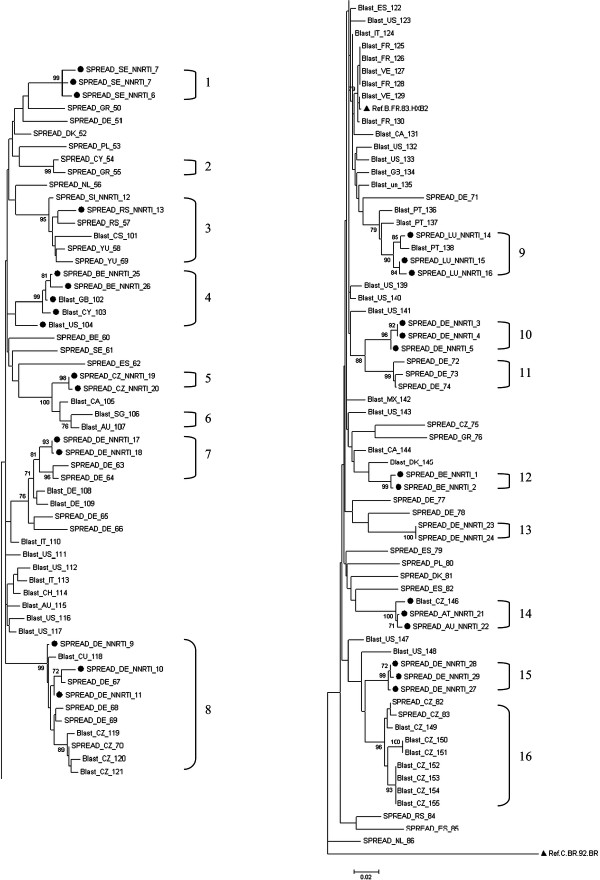
The K103N mutation in phylogenetic analyses of HIV-1 subtype B pol sequences. The reliability of tree topologies was assessed by bootstrapping with 1000 replicates. A bootstrap support of 70%, or greater, are shown at nodes on the tree. The source of the data, the country of residence, and the presence of an NNRTI resistance mutation are included in the sequence-label. The 16 square brackets show patients in a phylogenetic cluster with bootstrap support of >70% and a mean genetic distance of <0.03 nucleotide substitutions per site; (●) indicated patients with a K103N mutation; (▲) highlights a reference sequence.